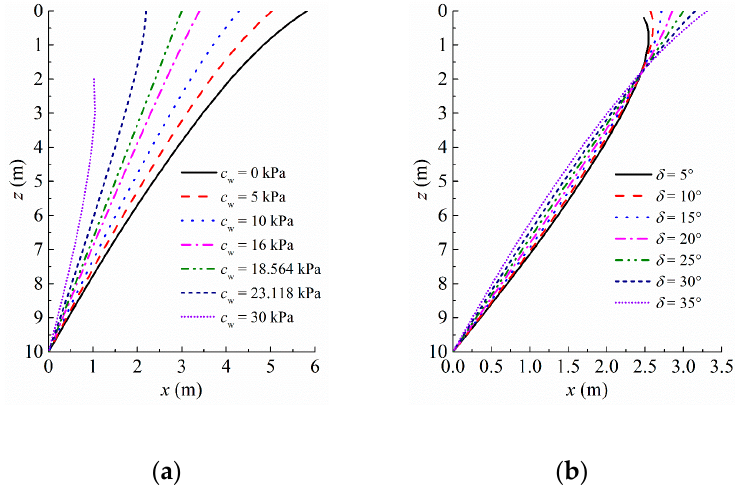
Figure 4. Influence of (a) c w and (b) δ on the slip surface.